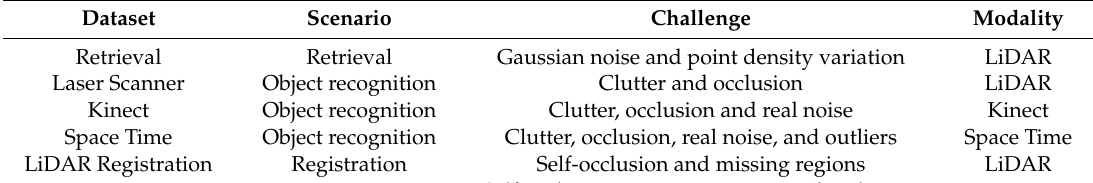
Table 1. Experimental datasets and relevant properties [2 0].